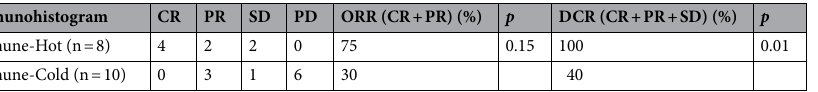
Table 3. Association between immunohistogram and objective response to ICI therapy. CR, complete response; PR, partial response; SD, stable disease; PD, progressive disease; ORR, objective response rate; DCR, disease control